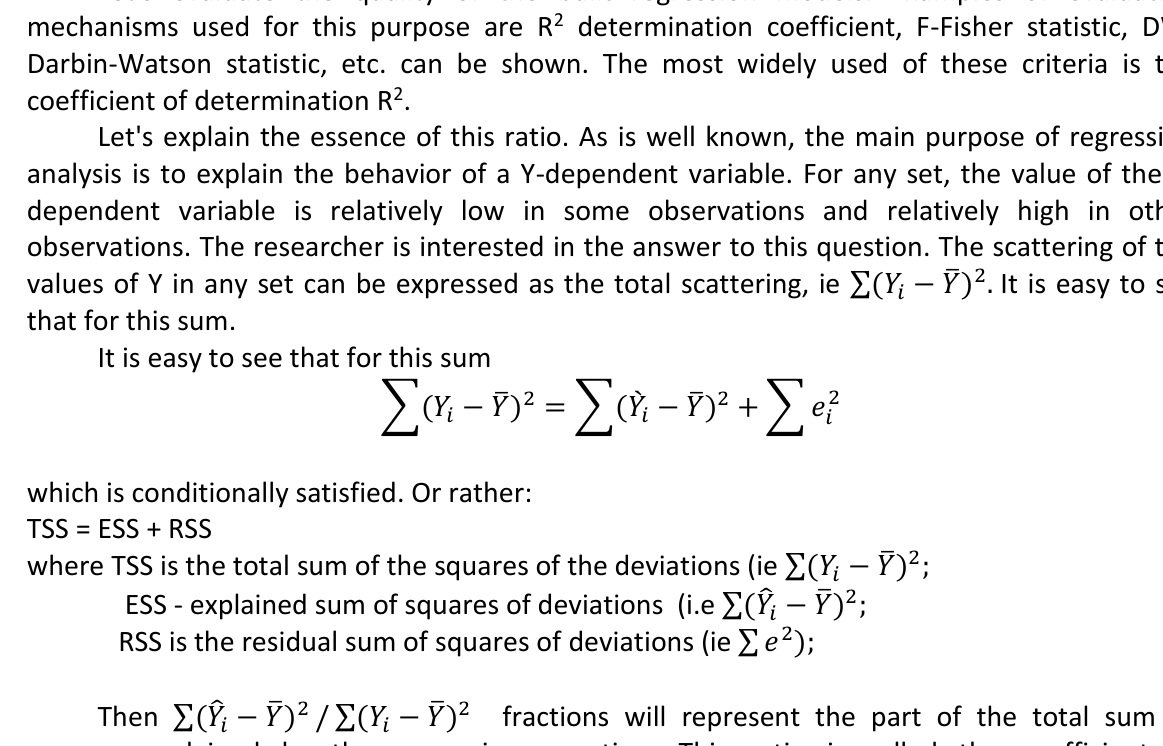
Fisher statistics Darbin - determination